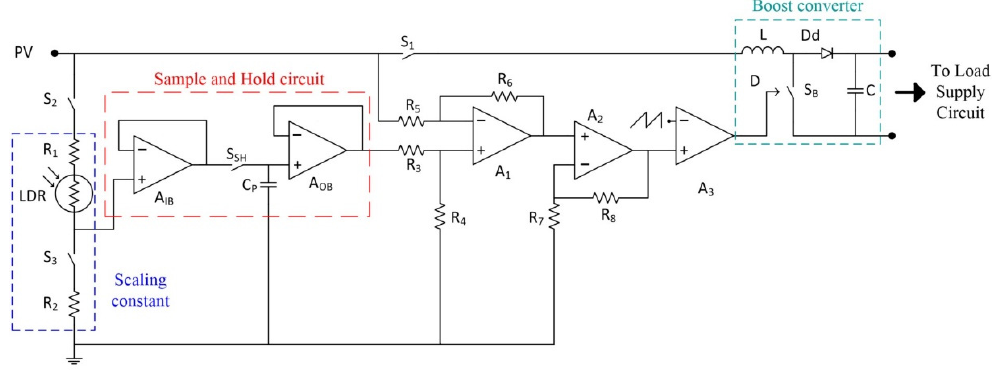
Figure 2. The proposed FOCV MPPT circuit.